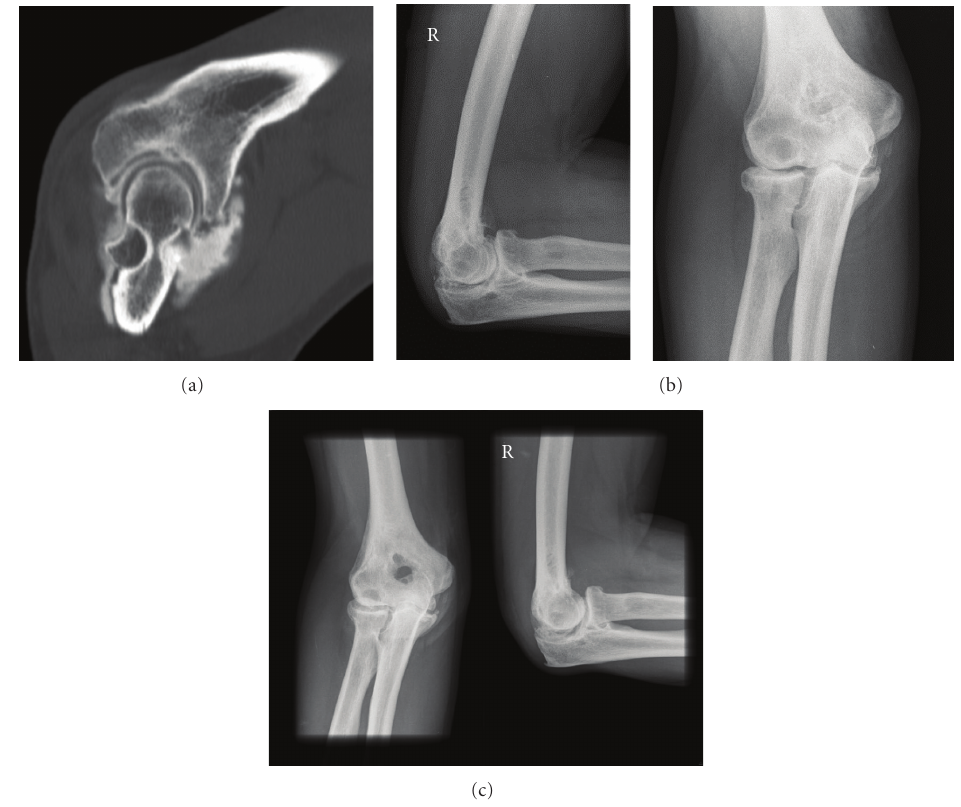
Figure 2: Radiological assessment with CT scan of early cubarthritis shows the posterior impingement in extension (a). Pre- (b) and postoperative (c) X-rays of the perforation of the distal